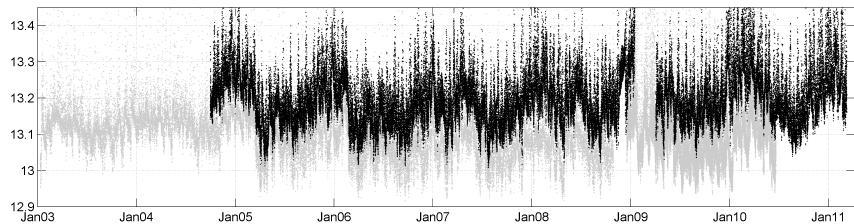
Fig. 4. θ time series of the MW outflow at CAS (grey dots, at 270m) and at ES (black dots, at 356m).